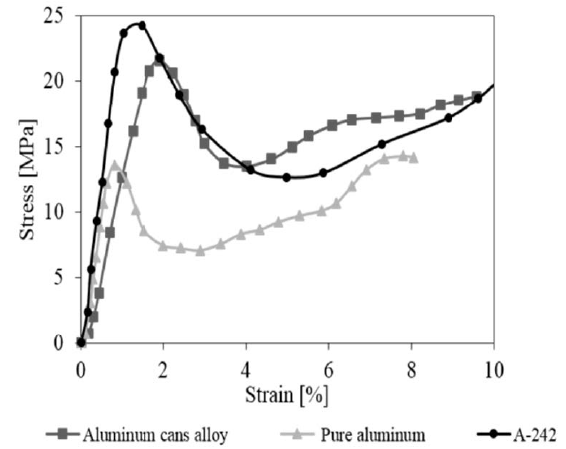
Figure 7. Stress–strain curves of a pure aluminium foam, an aluminium foam of an alloy prepared from beverage cans, and foams prepared with the A-242 aluminium alloy prepared in this work.